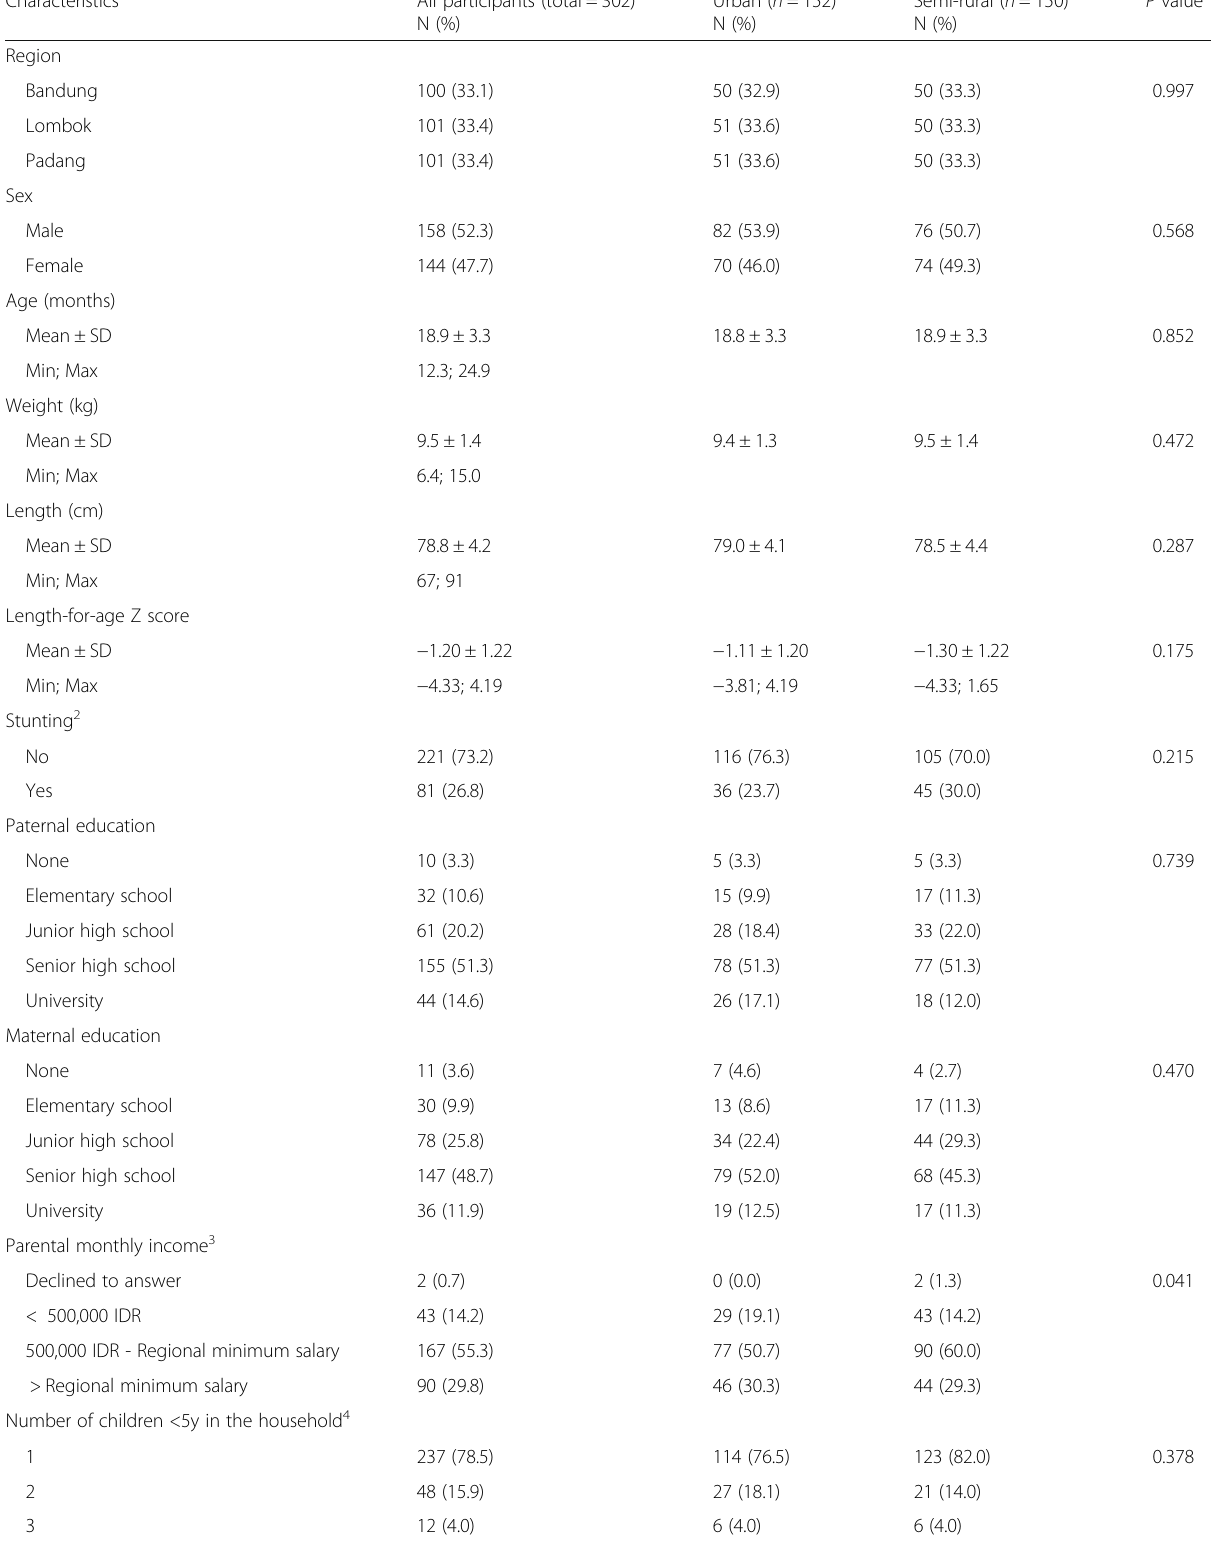
Table 1 Characteristics of study participants